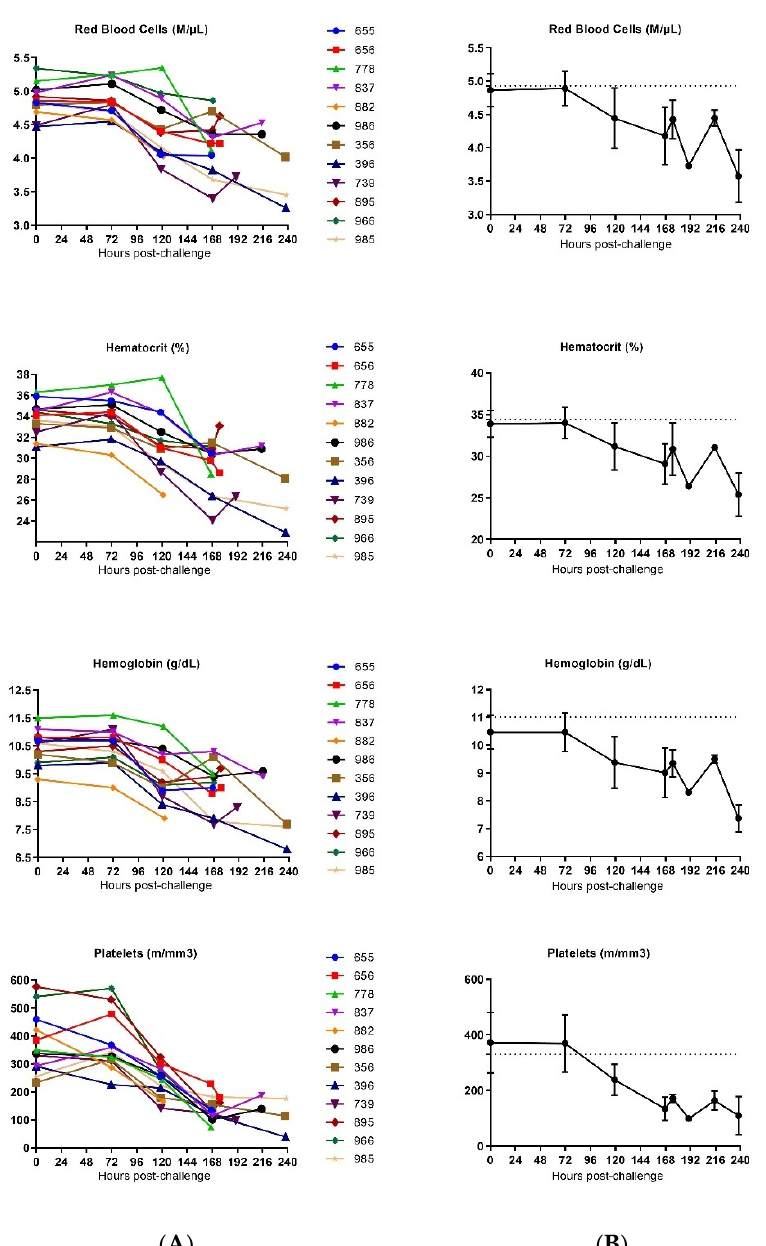
Figure 8. Hematological analysis in SUDV-challenged animals. ( A ) Individual hematological parameter evolution versus time. ( B ) Group mean hematological parameter evolution versus time. Average measurements taken before exposure serve as baseline (represented by horizontal straight dashes lines). Error bars represent the standard error of the mean.